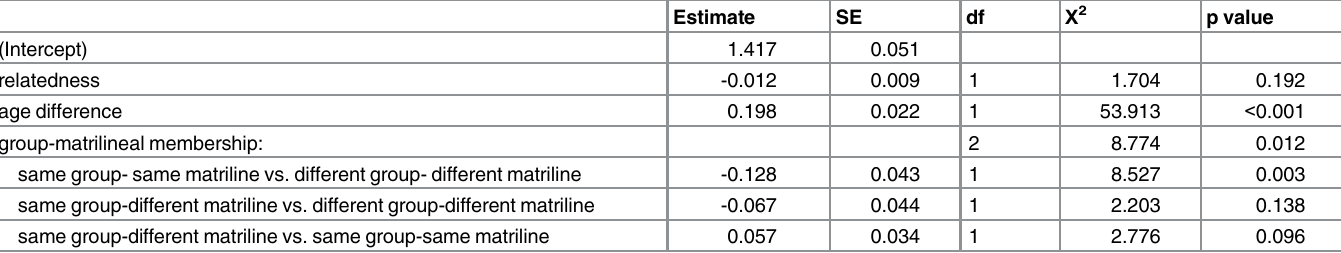
Table 3. Results of the reduced model (without the non-significant three- and two-way interactions) testing the effect of relatedness, matrilineal- group membership and age difference on acoustic distance between dyads.